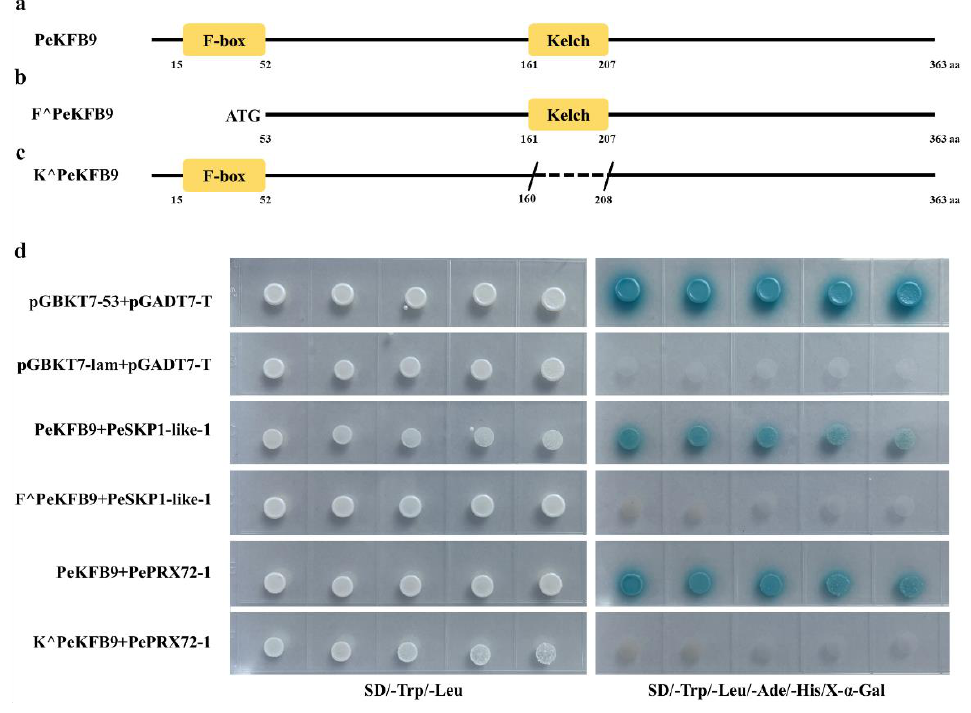
Figure 7. PeKFB9 physically interacted with PeSKP1-like-1 and PePRX72-1. ( a – c ) Schematic diagram showing the predicted F-box and Kelch repeat domains in PeKFB9, FˆPeKFB9, and KˆPeKFB9. ( d ) Yeasts carrying activation domain (AD) (pGADT7-PePRX72-1 and pGADT7-PeSKP1-like-1) and binding domain (BD) (pGBKT7-PeKFB9, pGBKT7-FˆPeKFB9, and pGBKT7-KˆPeKFB9) vectors grown on double dropout (-Leu/-Trp) and quadruple dropout (-Leu/-Trp/-His/-Ade) synthetic defined medium supplemented with X- α -Gal. Yeast harboring pGBKT7-53 and pGADT7-T vectors served as a positive control; yeast harboring pGBKT7-Lam and pGADT7-T vectors served as a negative control.